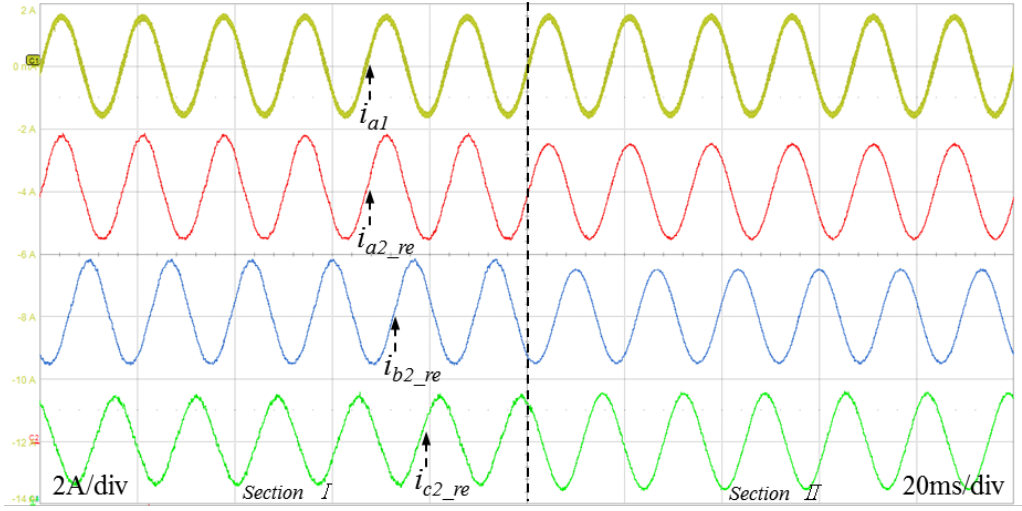
Figure 12. The actual current and reconstructed currents of the three phase current before and after the proposed offset compensation algorithm is applied in the inverter 2.